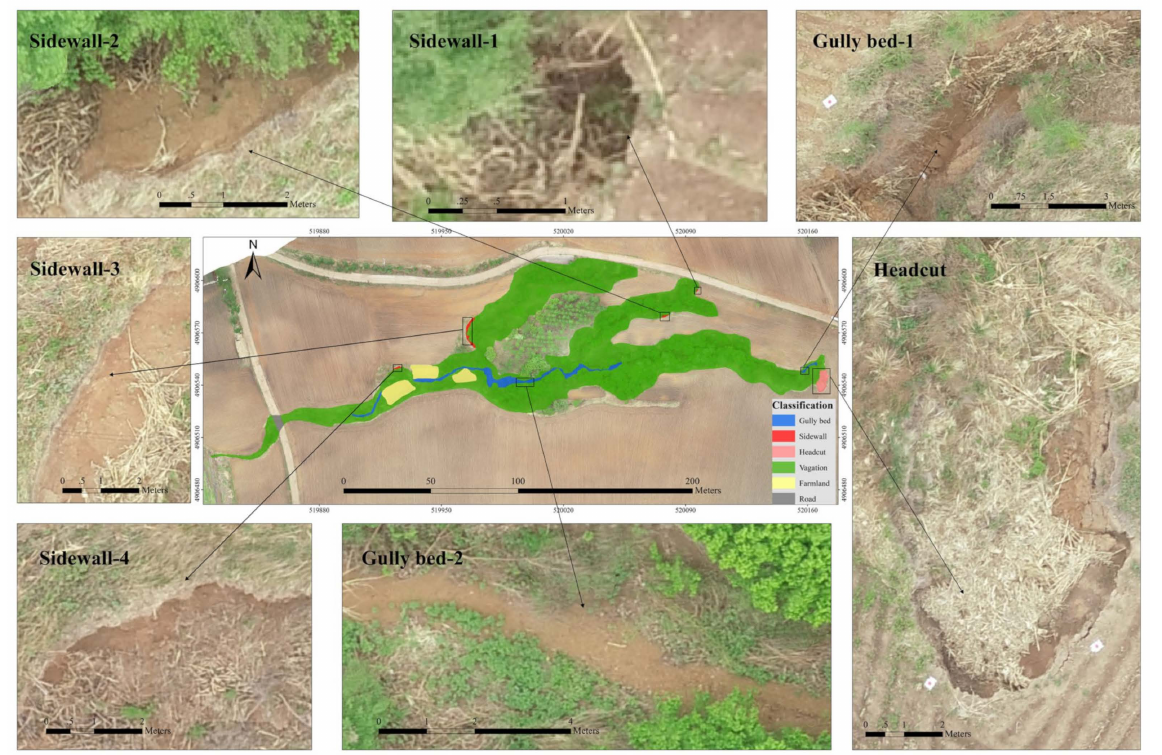
Figure 7. Classification of ground objects in the gully (P4R UAV orthophoto image obtained on 19 May 2019).